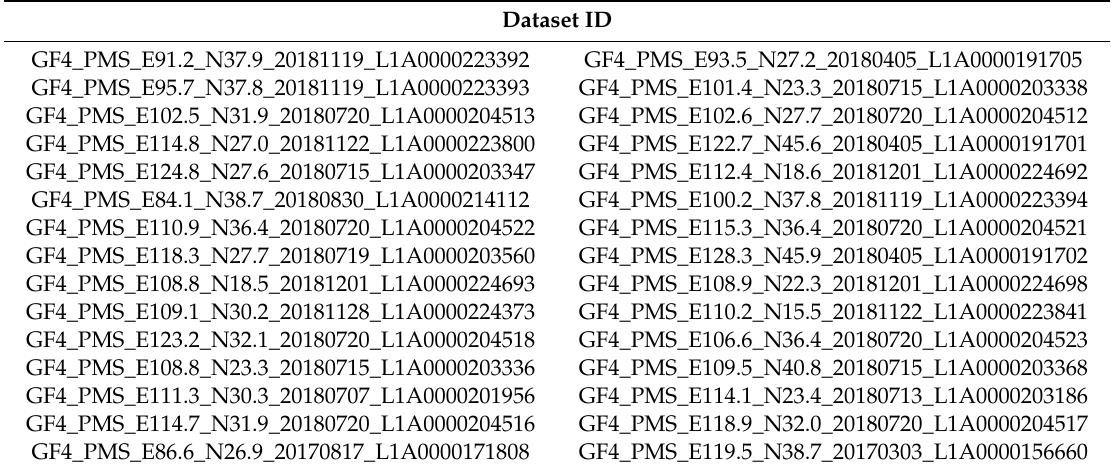
Table 3. The reference data used in this